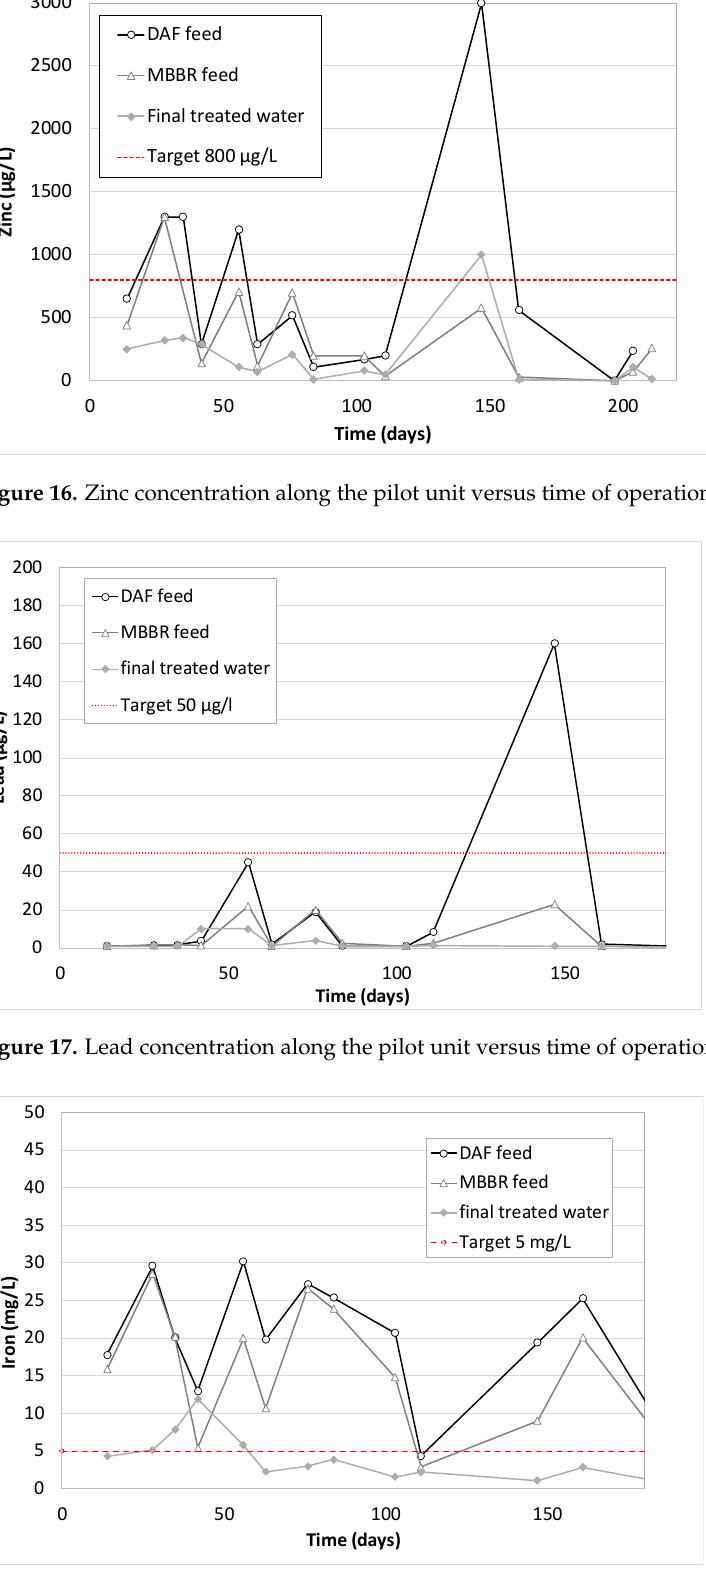
Figure 18. Iron concentration along the pilot unit versus time of operation.